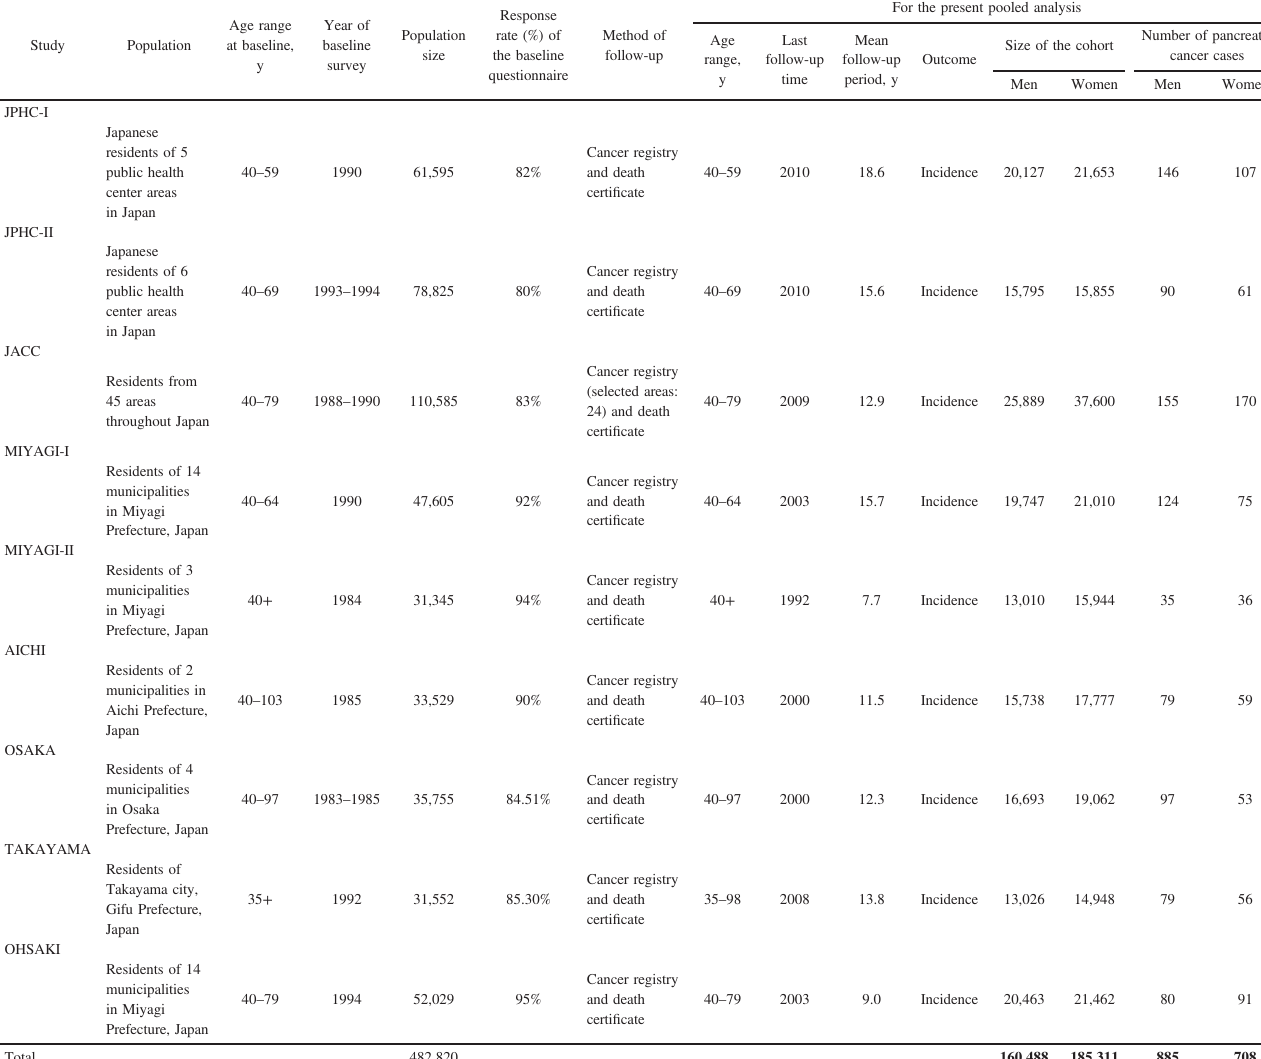
Table 1. Characteristics of the cohort studies in the present pooled